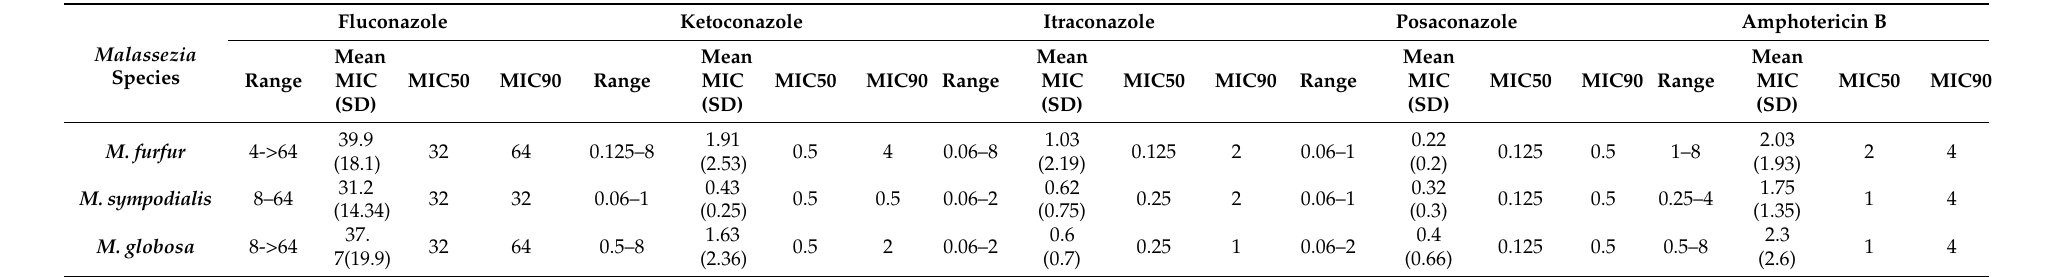
Table 2. Fluconazole (FLZ), ketoconazole (KTC), itraconazole (ITZ), posaconazole (POS), and amphotericin B (AMB) minimum inhibitory concentration